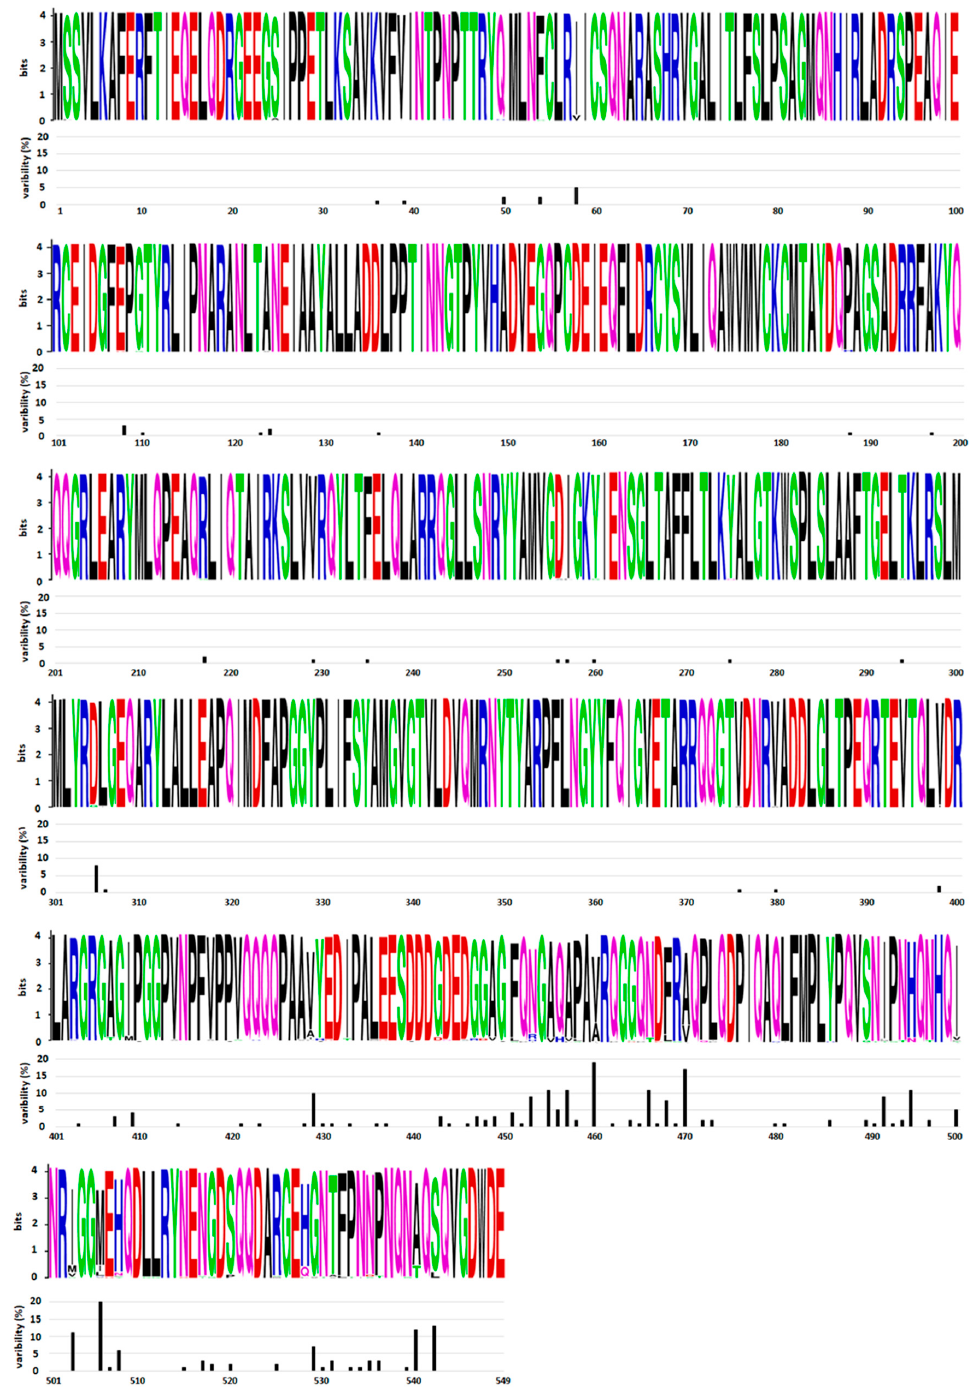
Figure 3. Distribution of amino acid substitutions in the mumps virus NP. Variability of the 82 mumps virus NP sequences from GenBank was analyzed. WebLogo was used to generate mumps virus nucleoprotein sequence logos (Crooks et al., 2004, https://weblogo.berkeley.edu/, accessed on 13 January 2022). Amino acid single letter annotation was used for each position in the sequence. The height of the column denotes the conservation of each amino acid position, while the height of the amino acid letter within the column indicates the relative frequency. Variability of each amino acid position is indicated below each logo